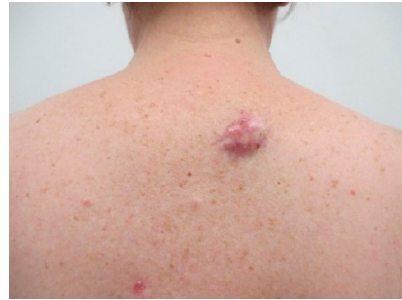
Figure 7. Scalp cylindromas and spiradenomas. Reports 2020 , 3 , x FOR PEER REVIEW